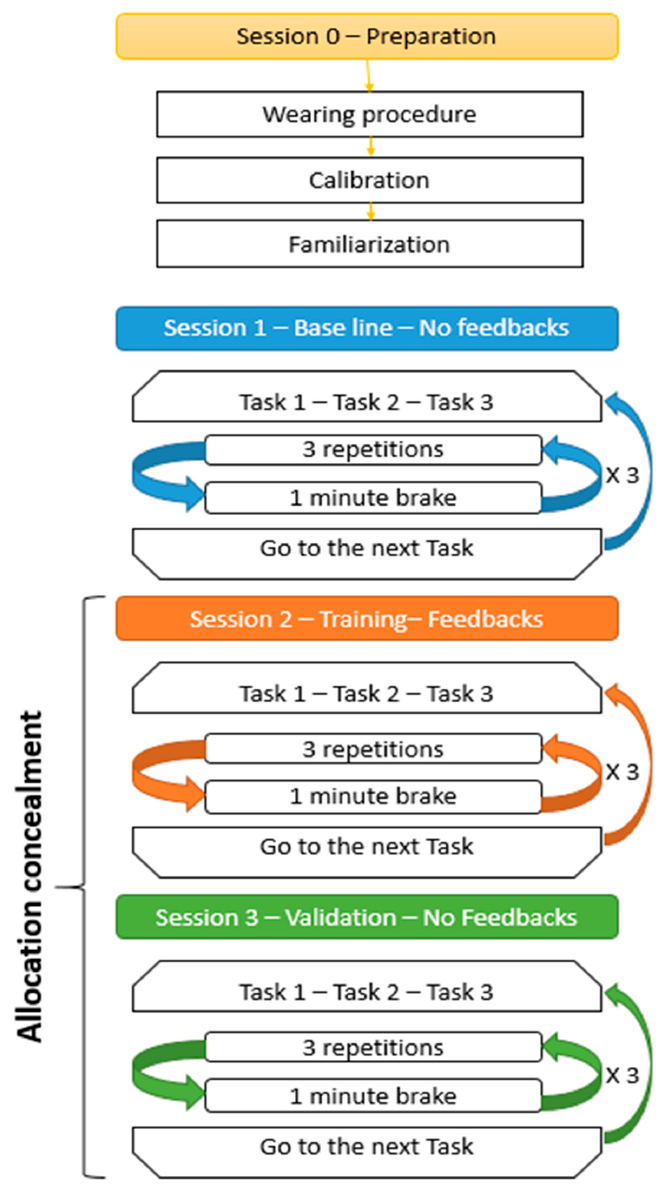
Figure 3. Experimental procedure: sessions and cycle structure.